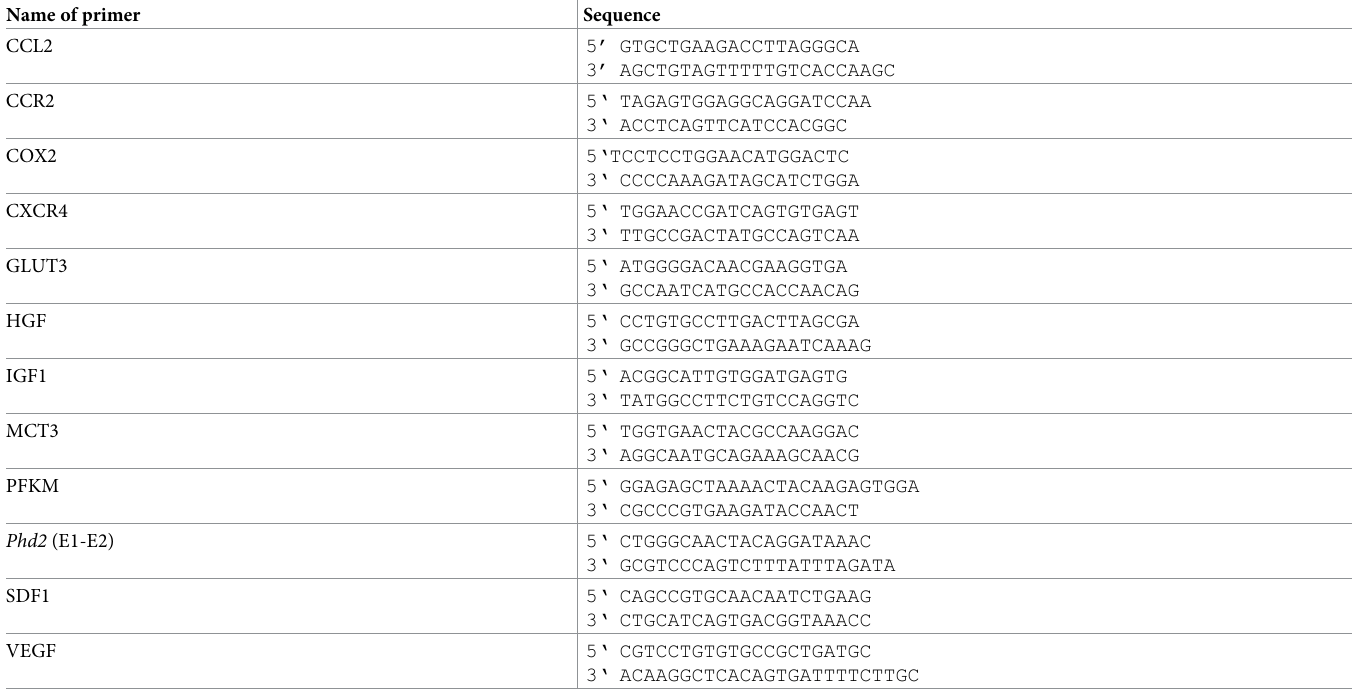
Table 1. List of primers and sequences. Name of